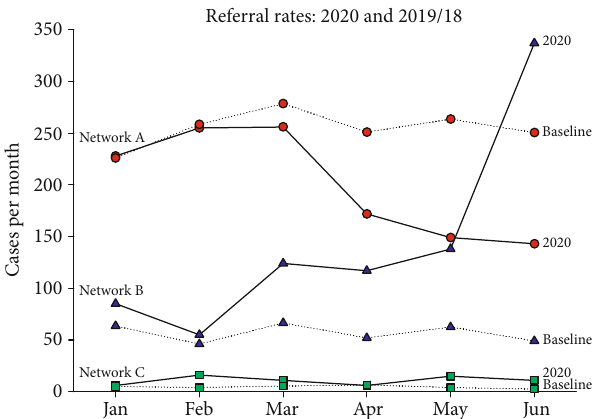
Figure 2: Referral rates in the three networks surveyed. Numbers of cases per month are shown for the year 2020 (solid lines), while the baseline values indicate the average numbers of cases during the corresponding months in 2019 and 2018 (dotted lines).